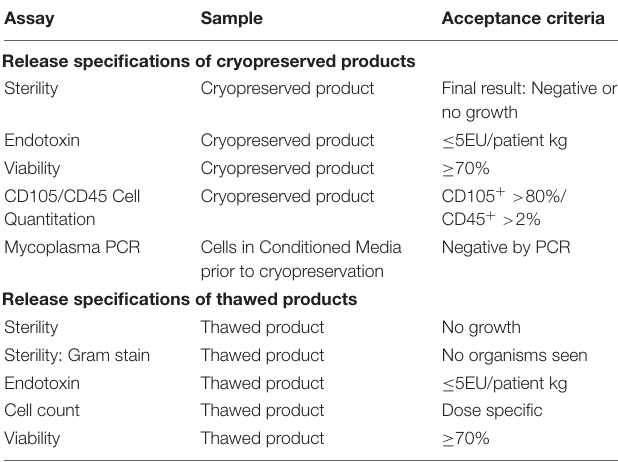
TABLE 1 | Release specifications of cryopreserved and thawed MSC products.